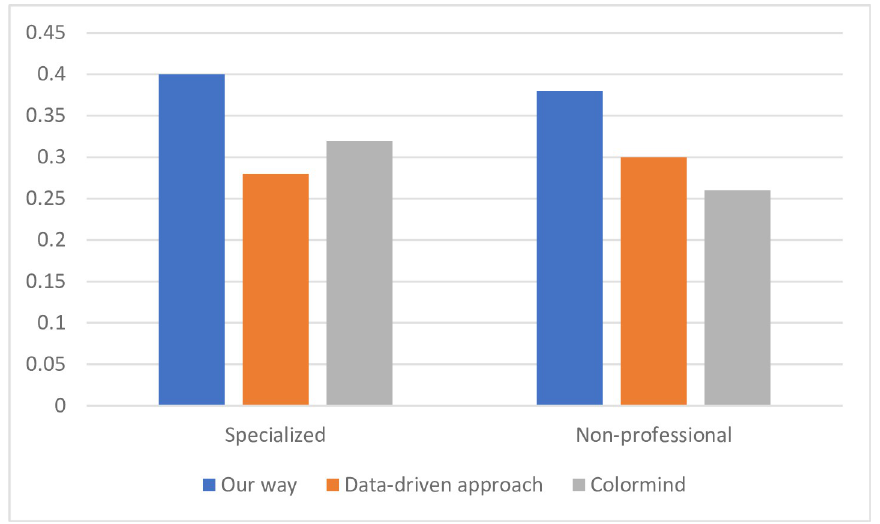
Fig 4. Method comparison analysis